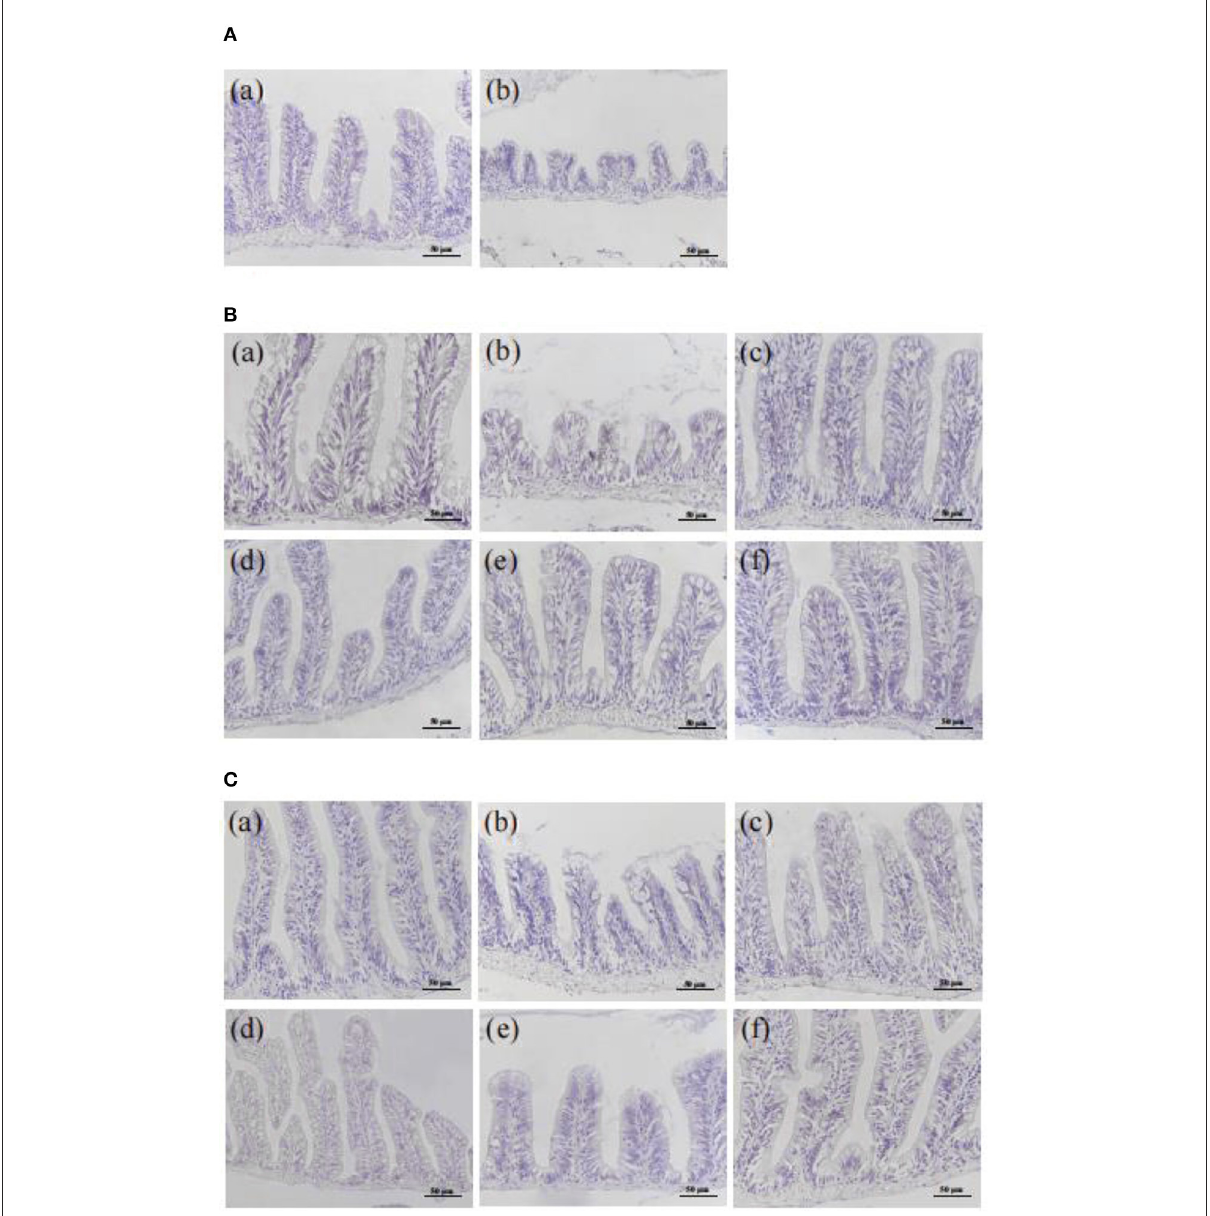
FIGURE3 Effect of CMFPs on the histopathological structure (HE staining) of intestinal in inflammatory bowel disease zebrafish. (A) 5h. (B) 3 d. (C) 6 d. (a) NC group. (b) MC group. (c) CMFP-H group. (d) CMFP-I group. (e) CMFP-F group. (f) PC group.